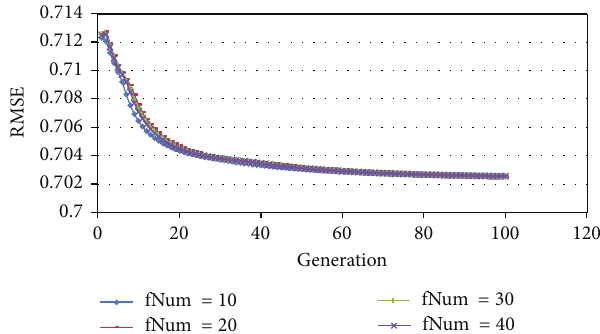
Figure 3: The effects of feature dimension on RMSE.